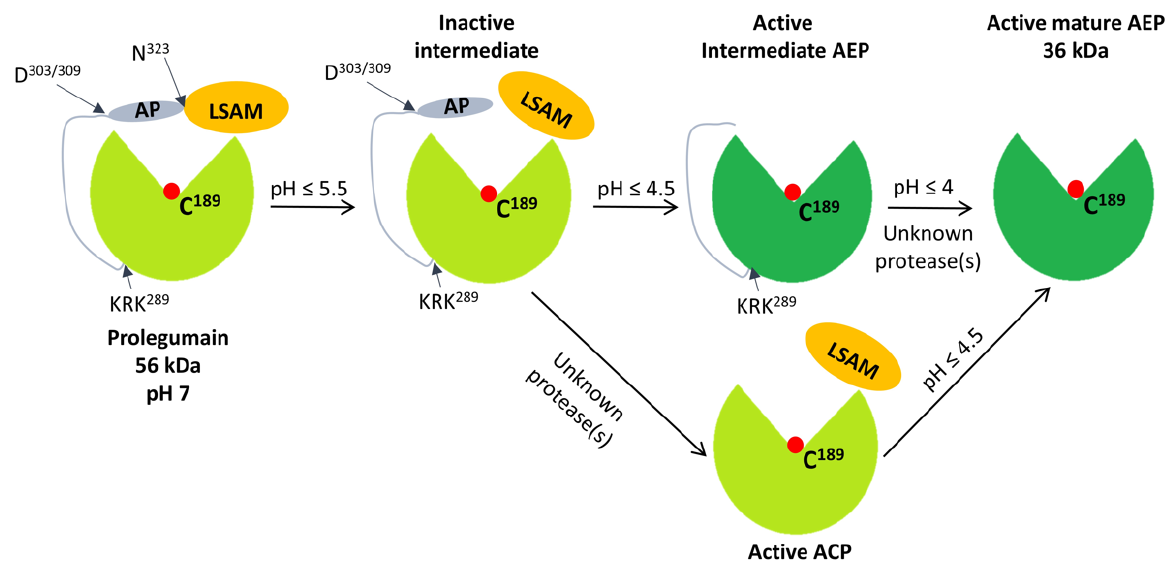
Figure 1. Illustration of legumain activation. Inactive prolegumain (56 kDa) is composed of the catalytic domain (light green), activation peptide (AP, grey), and legumain stabilization and activity modulation domain (LSAM, orange), and is stable at a neutral pH. The proenzyme undergoes autocatalytic processing at asparagine 323 (N323) at pH ≤ 5.5 and at aspartate 303/309 (D303/309) at pH ≤ 4.5. Another in trans processing occurs after the KRK289 motif by unknown protease(s). Release of the LSAM domain is mandatory to gain AEP activity (dark green) and the cysteine (C189) in the catalytic site is marked (red dot). In addition, ACP activity is obtained when the LSAM remains electrostatically bound, whereas the AP is removed. A decrease in pH causes protonation and release of the LSAM domain and legumain acquires AEP activity. The amino-terminal cleavage after aspartate 21 (D21) and 25 (D25) is not shown. AEP, aspaparaginyl endopeptidase; ACP, asparaginyl